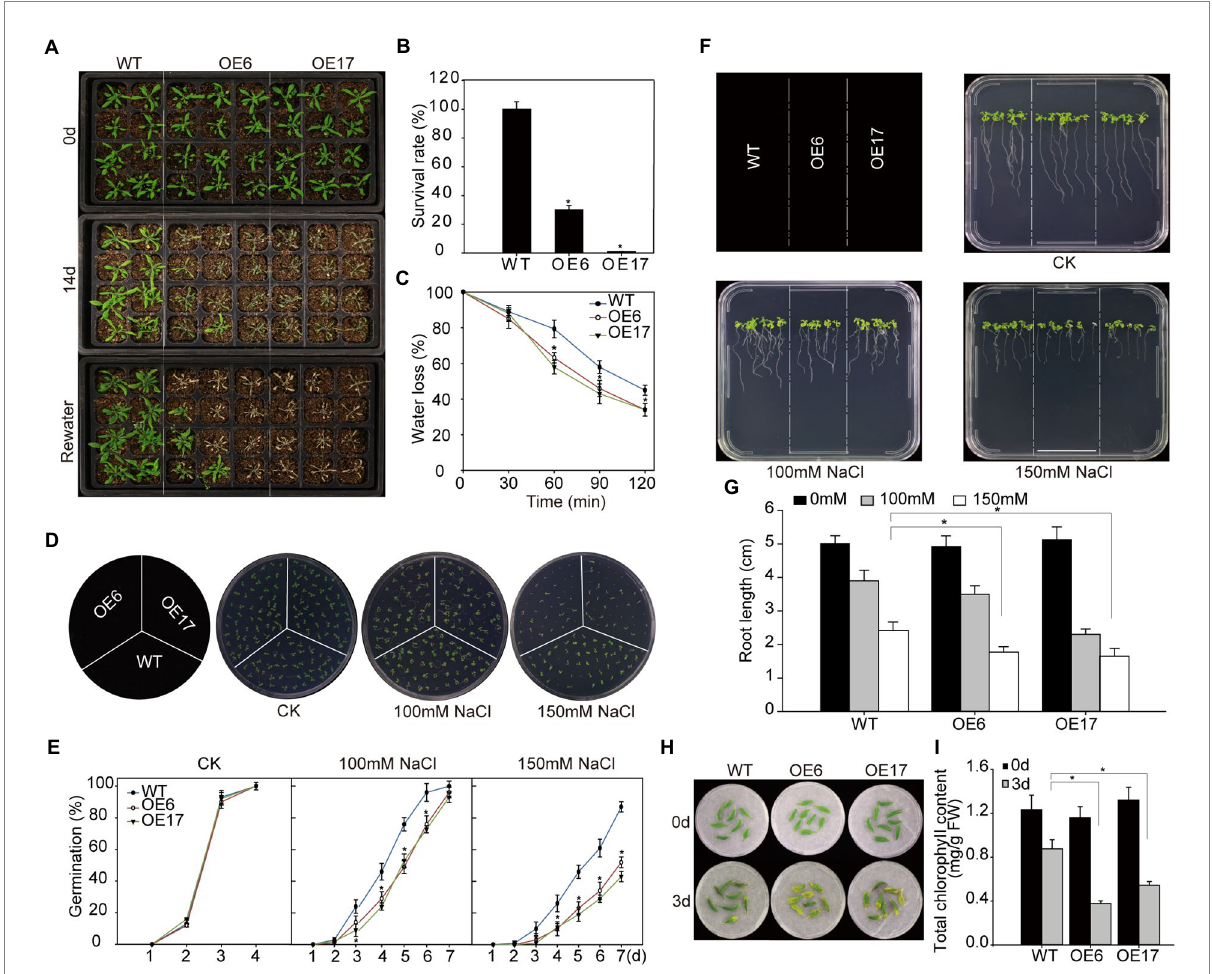
FIGURE 4 Overexpression of NtNAC028 confers hypersensitivity to abiotic stress in transgenic Arabidopsis . (A) Phenotypes of NtNAC028 overexpression lines (OE6 and OE17) and WT under drought stress treatments. Four-week-old NtNAC028 overexpression lines and WT were withheld from watering for 14 days, followed by re-watering and recovery for 3 days. (B) Survival rates of NtNAC028 overexpression lines and WT after drought stress. (C) Water loss rates of detached leaves from NtNAC028 overexpression lines and WT. (D,E) Germination of WT and NtNAC028 overexpression lines with different concentrations of NaCl as indicated. Representative images were taken after 7 days. (F,G) Root length of NtNAC028 overexpression lines and WT seedlings under NaCl treatments. Seedlings were vertically grown for 7 days on 1/2 MS plates containing 0, 100, or 150 mM NaCl. (H,I) The phenotypes and chlorophyll content of detached leaves from WT and NtNAC028 overexpression lines under NaCl treatments for 3 days. The bars are standard deviations (SD) of three biological replicates. Asterisks indicate statistically significant difference from WT (* p <